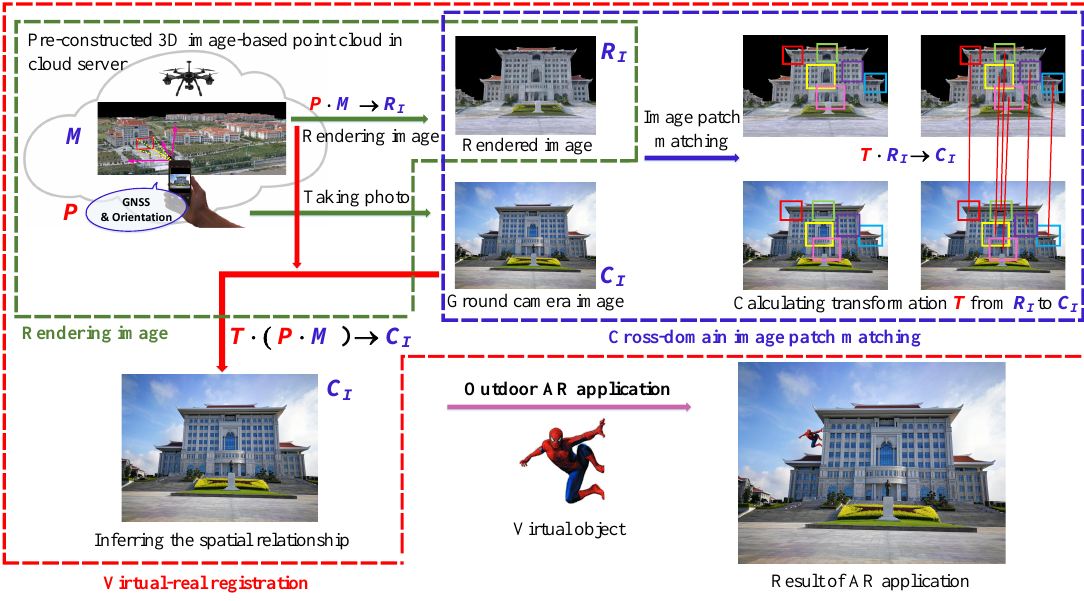
Figure 1. Overview of the proposed AR virtual–real registration approach in outdoor environments. Within the green dashed bounding box is the schematic of the synthetic image rendered from the 3D image-based point cloud; within the blue dashed bounding box is the cross-domain image patch matching by the invariant feature descriptors learned through the proposed AE-GNA-Net; within the red dashed bounding box is the virtual–real registration. The symbols represent the following: M : 3D image-based point cloud; C I : Ground camera image; R I : Synthetic image rendered from 3D image-based point cloud; P : Position information from mobile phone; T : Transformation relationship from R I to C I